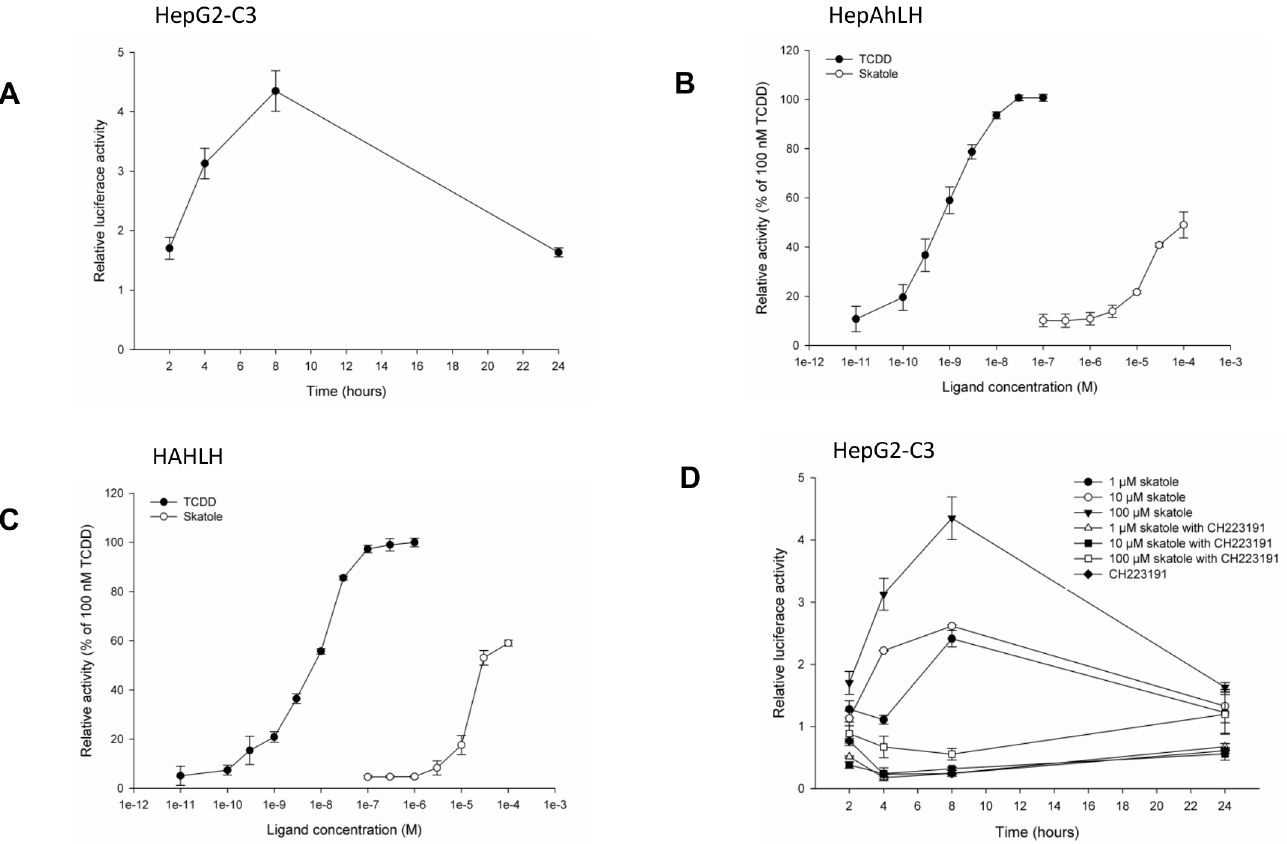
Fig 1. Skatole activates AhR. (A) Luciferase activity in HepG2-C3 cells transiently transfected with the pTXINV-XRE reporter plasmid and incubated with 100 μ M skatole for 2, 4, 8 or 24 h (n = 3). Luciferase activity measured in HepAhLH (B) or HAhLH (C) cells, in which the luciferase reporter gene is controlled by the XRE 5 (TnGCGTG) 3, after incubation with skatole (from 1.10 − 7 M to 1.10 − 4 M) or TCDD (from 1.10 − 11 M to 1.10 − 7 M) for 8 h (n = 3). Luciferase activity was expressed as the percentage of the activity obtained by incubation with 1.10 − 7 M TCDD. (D) Relative luciferase activity measured in HepG2-C3 cells transfected with pTXINV-XRE and incubated with 1, 10 or 100 μ M skatole for 2, 4, 8 or 24 h, following 30 min pre- incubation with DMSO (control) or 3 μ M CH223191 (a specific AhR antagonist) (n = 3). In Fig 1D, are all data points significantly different (p < 0.05) form its time-matched CH 223191 treated counterpart, except for control and 100 μ M skatole at time point 24 hours.